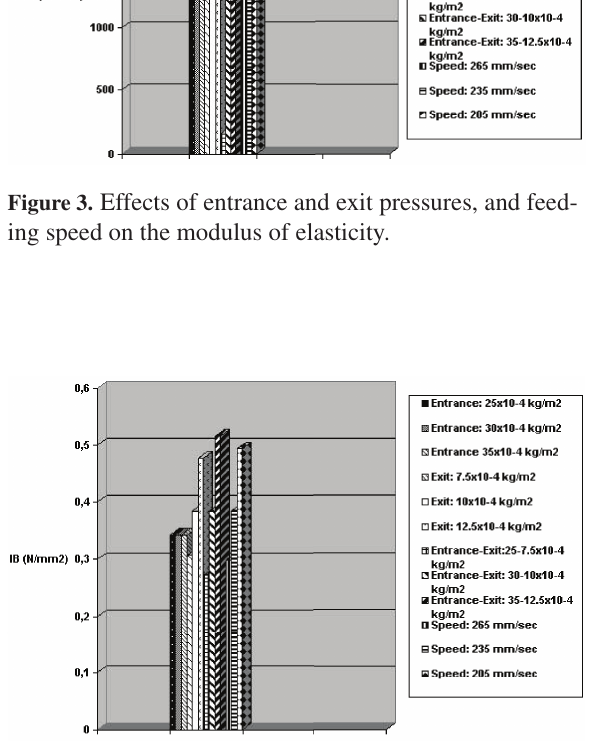
Figure 4. Effects of entrance and exit pressures and feeding speed on the internal bond strength.